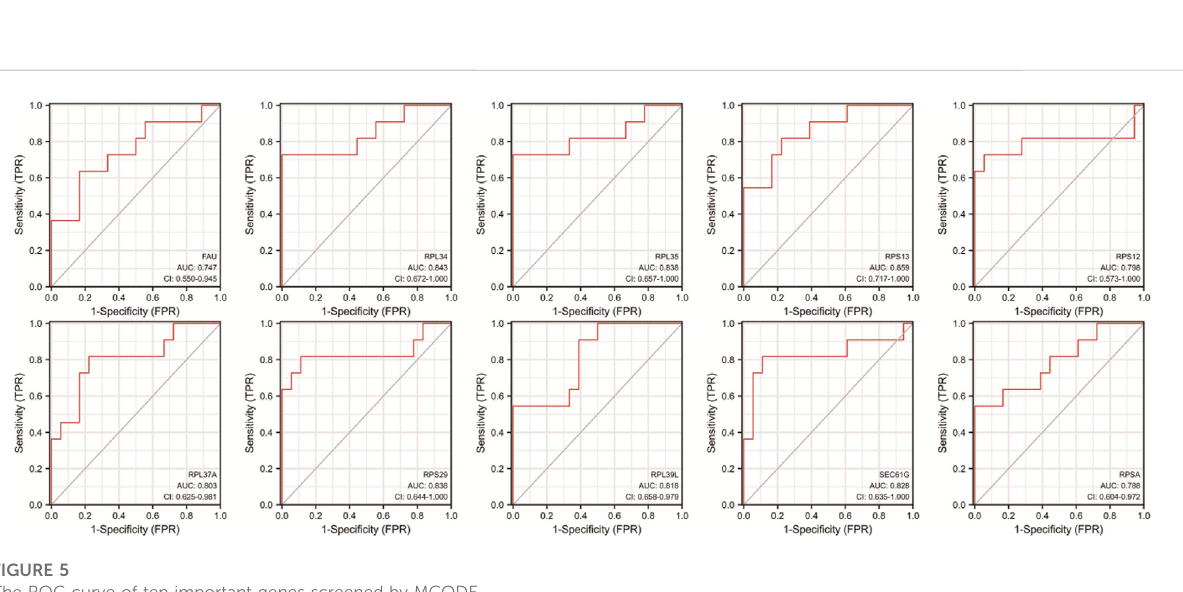
FIGURE 5 The ROC curve of ten important genes screened by